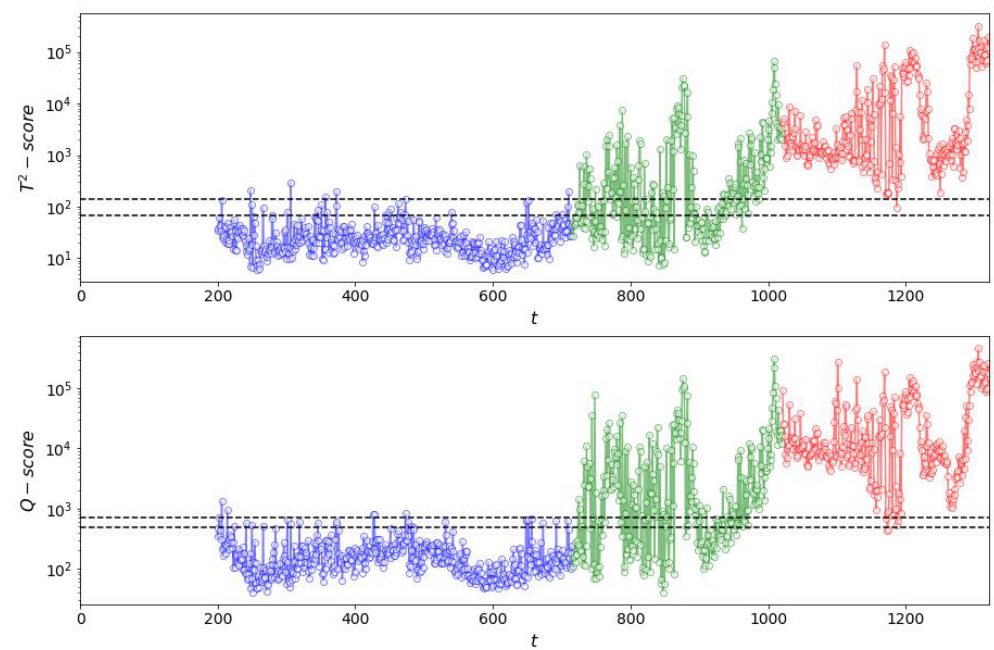
Figure 26. T 2 ( top ) and Q ( bottom ) process monitoring charts of multivariate grinding circuit data for a window length of 100 time steps using Method II. Training non-fault data are shown in blue, untrained non-fault data in green and test (fault) data in red.